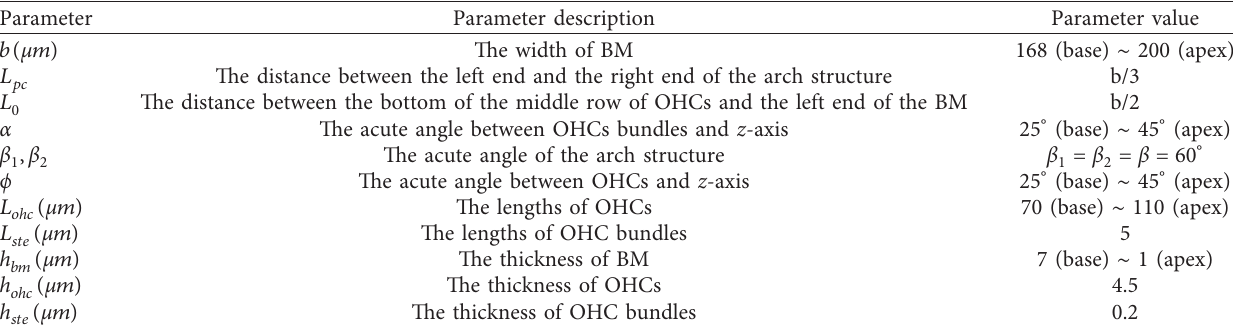
Table 1: Geometric data of each part of OC.